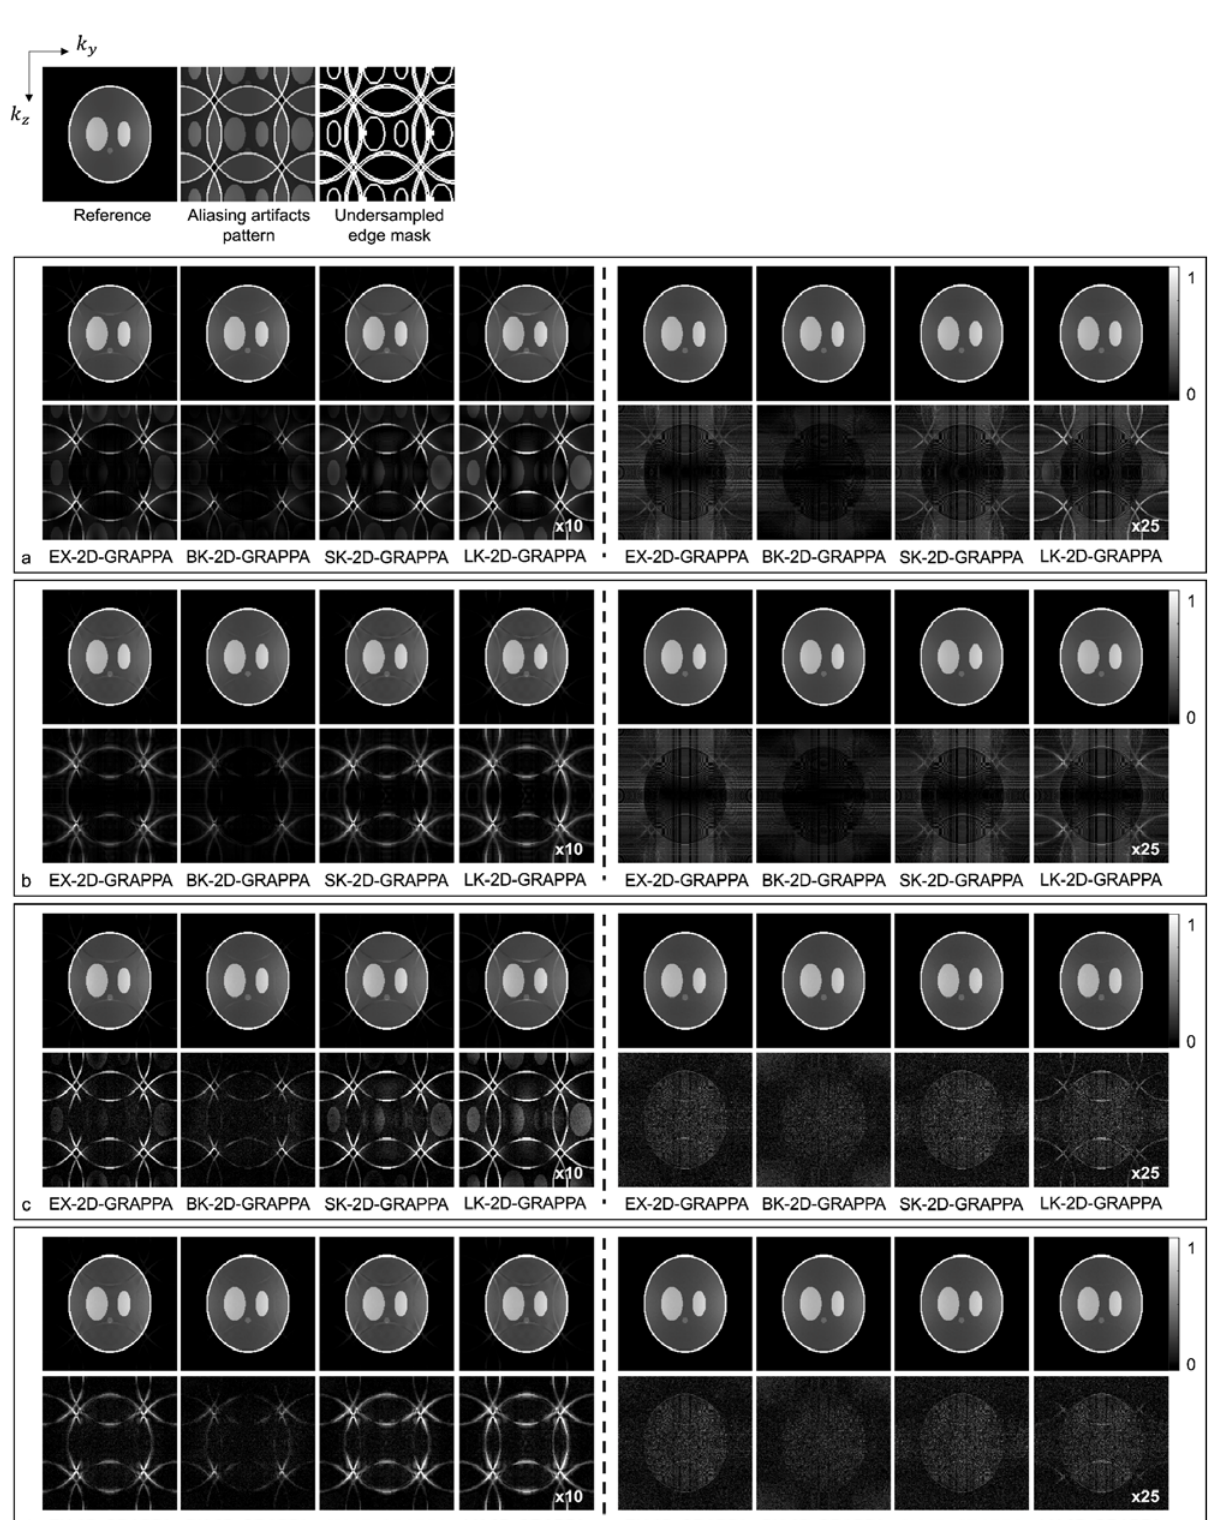
Figure 5. The images reconstructed by different 2D-GRAPPA algorithms from ( a , b ) noise-free and ( c , d ) 30 db noise-added simulation data with AF = 4 (2 × 2). The 24 × 24 k-space reference lines were ( a , c ) excluded and ( b , d ) included for reconstruction. Columns 1–4: basis kernel. Columns 5–8: expanded kernel.